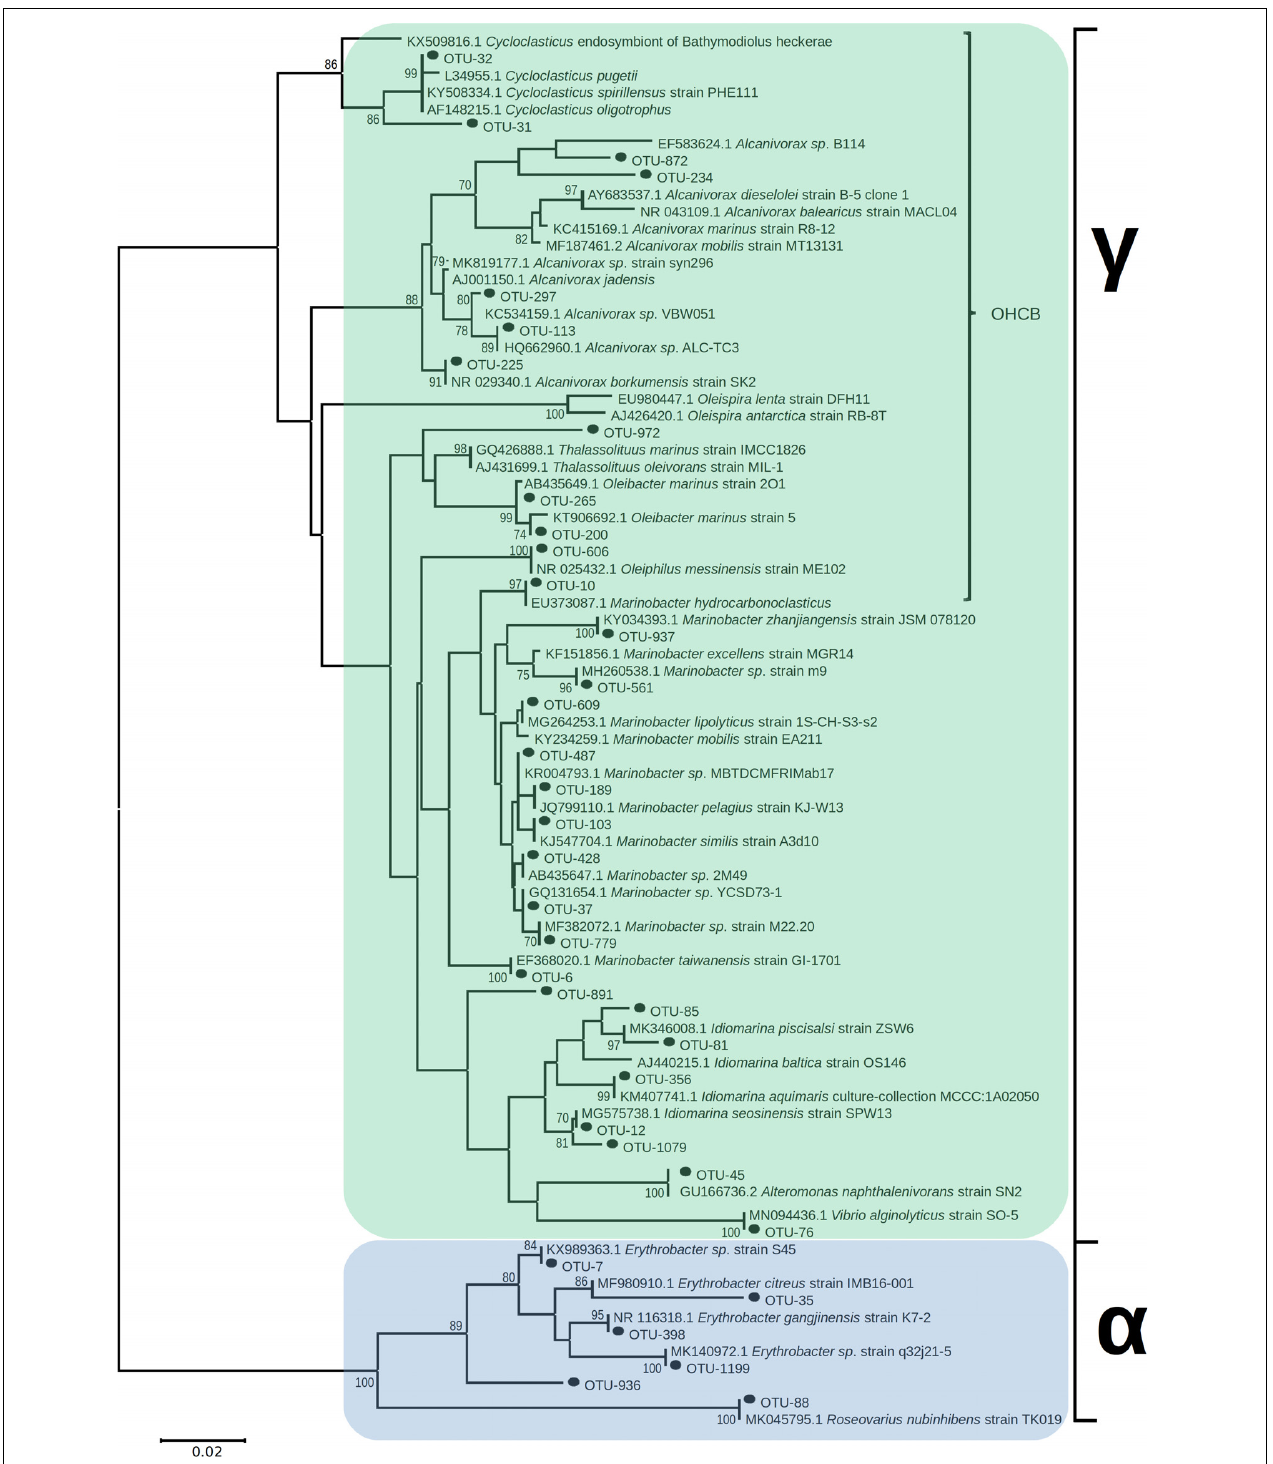
FIGURE 6 | Unrooted neighbor-joining phylogeny of 16S rRNA bacterial OTUs, in sediments from contaminated sites along the Athens Riviera and Salamina coastline, from September 2017 to April 2018, aligned with known hydrocarbon-degrading bacteria and closest relatives; bootstrap values > 70 displayed (1,000 iterations). Evolutionary distances computed by Maximum Composite Likelihood protocol (using the Tamura-Nei model, Tamura and Nei, 1993), sum of branch length = 1.15. Analysis involved 82 nucleotide sequences (36 OTUs) with a total of 258 positions in the final dataset. Evolutionary analyses were conducted in MEGA7. Bacteria and archaea OTU tables are available in Supplementary Tables S3 , S4